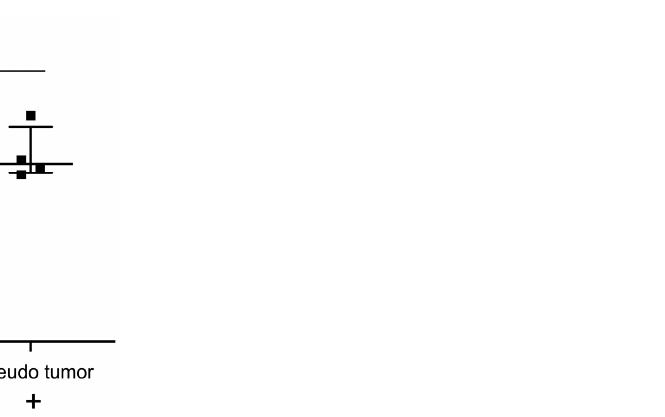
Figure 6. Visibility of periprosthetic muscles in the study cohort by ultrasonography and magnetic resonance image. In the anterior part, the iliopsoas, sartorius, and rectus femoris were detectable by MRI in 6.7%, 97.8%, and 44.4% of the HRA cases, although ultrasonography showed 100% of visi- bility of all these muscles ( A – C ). In the lateral part, the gluteus minimus and medius could be de- tected in 6.7% and 88.9% of the patients by MRI, and in 88.9% and 100% of these cases by ultraso- nography ( D , E ). The gluteus maximus and short rotators were detectable in 100% and 8.8% of the patients by MRI and 100% and 71.4% of the patients by ultrasonography ( F , G ). 4. Discussion Ultrasonography is an increasingly prevalent diagnostic modality in the orthopedic field due to advances made in the image resolution. In addition to its rapidity and con- venience, an advantage of ultrasonography for the screening of abnormalities in THA pa- tients has been its capacity to closely evaluate periprosthetic abnormalities that can be masked on an MRI or CT scan by metal halation. The early detection of implant related complications is vital in MOMTHA patients to avoid periprosthetic soft tissue damage due to ARMD [15,21,22]. In addition, abnormal periprosthetic reactions may be presenting through subtle symptoms [23]. As represented by ARMD, most implant-related compli- cations originate in periprosthetic soft tissues . Therefore, periprosthetic areas need to be